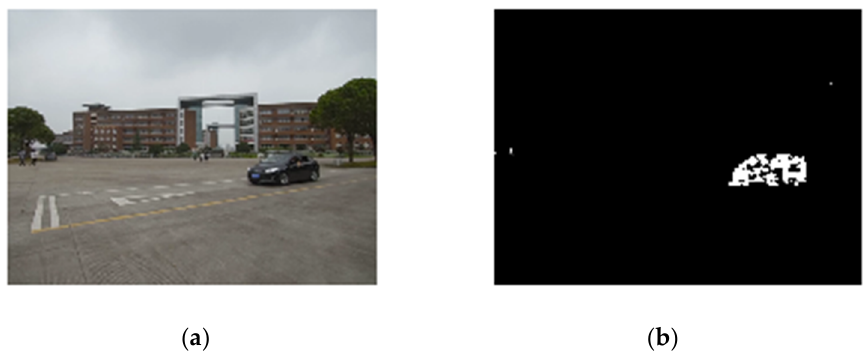
Figure 3. The result of moving object detection. ( a ) Original image; ( b ) foreground image.